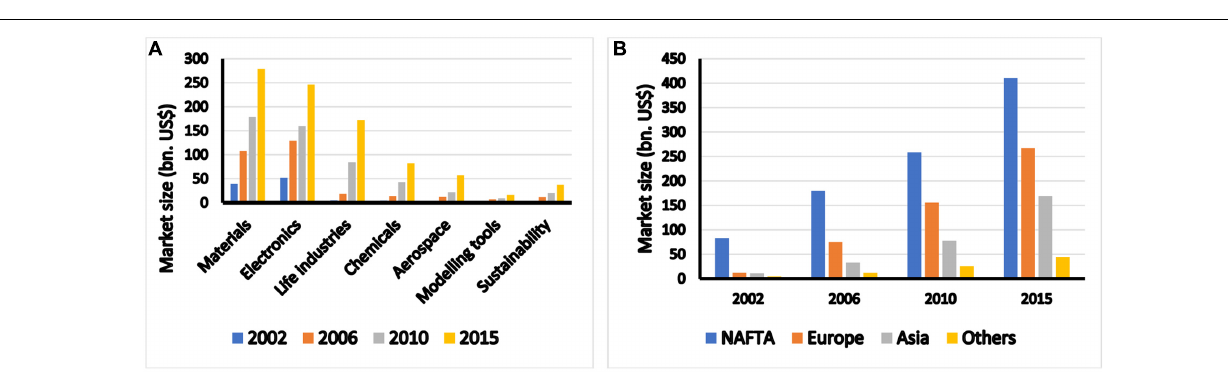
2008; Sertova, 2015; Fraceto et al., 2016). It also helps to